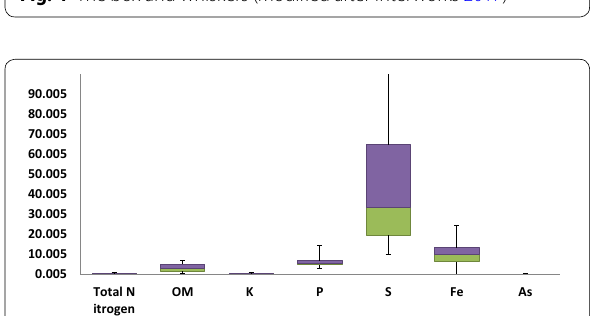
0.005 Fig. 5 The box-pot of all chemical